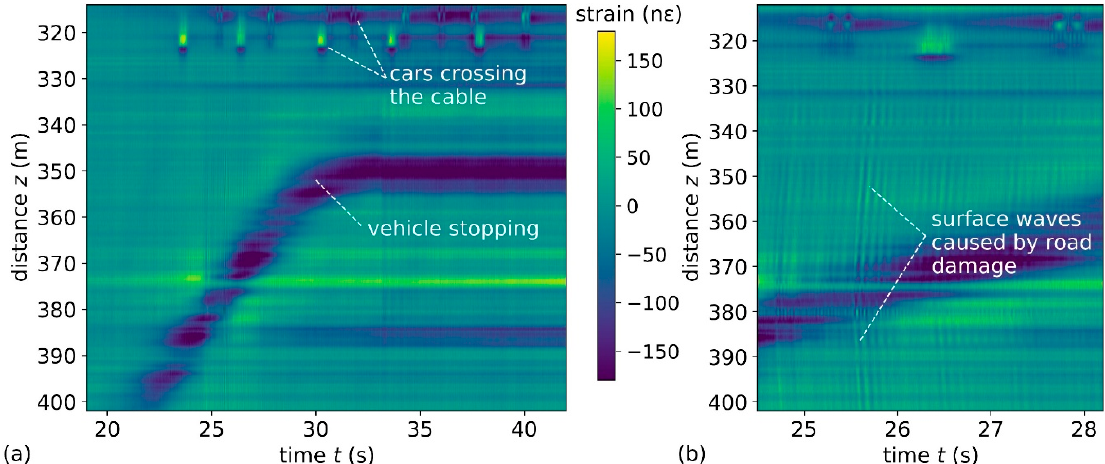
Figure 3. ( a ) Strain distribution along underground telecom cable parallel to a road, crossing a road at z ≈ 320 m. ( b ) Detail of ( a ): surface wave propagation indicating road damage ( f s = 1 kHz, f p = 50 kHz, 2 m spatial resolution, 20.4 cm sampling resolution, strain average of 3 samples along z and t